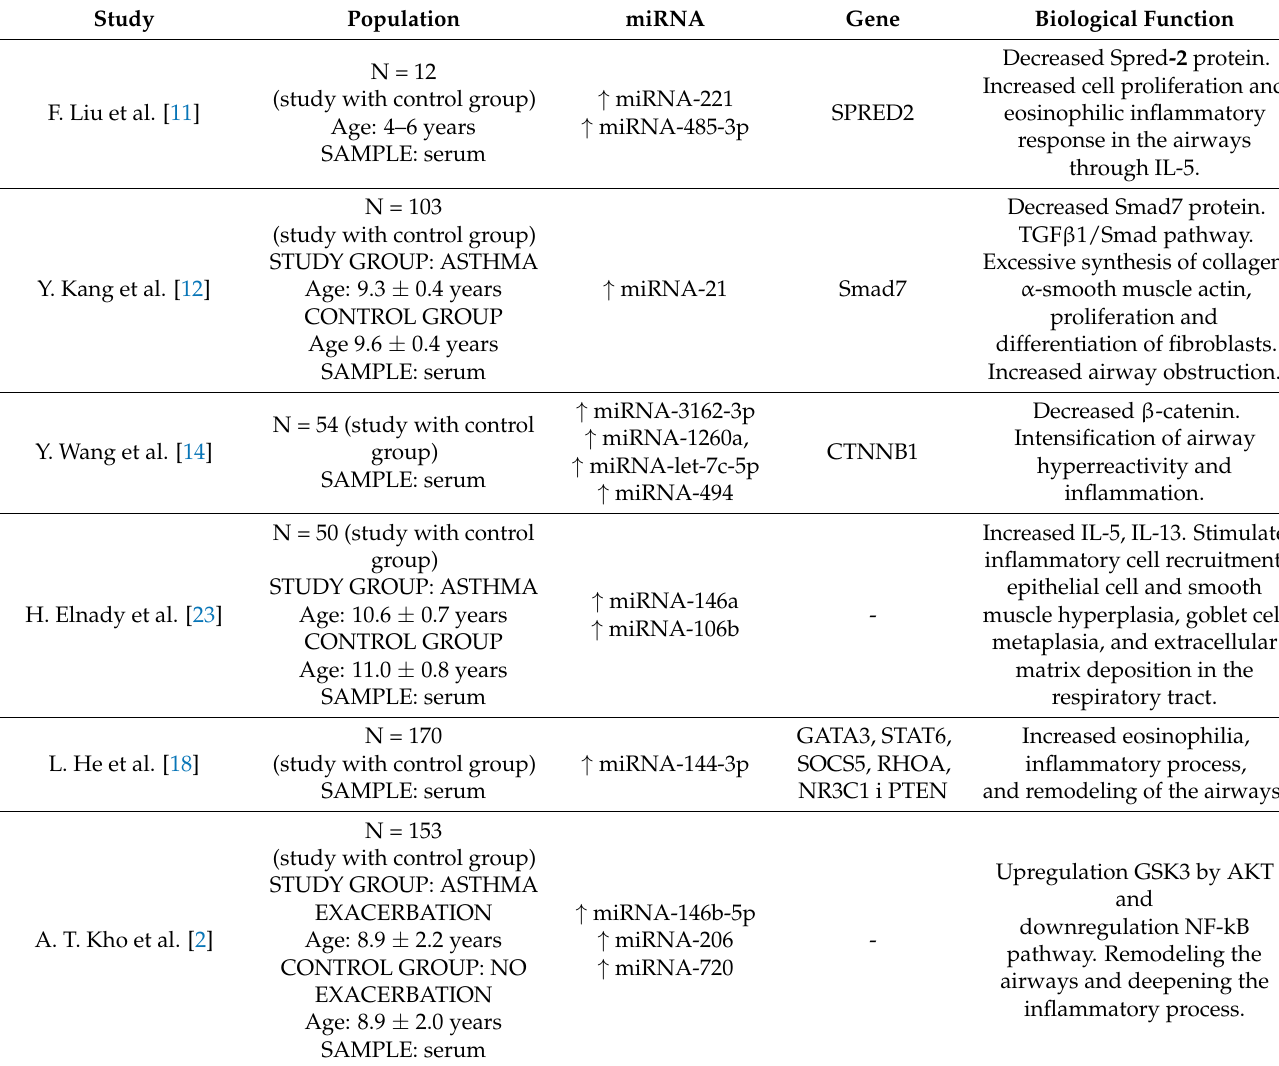
Table 1. The relevance of miRNA in asthma based on studies conducted in the pediatric